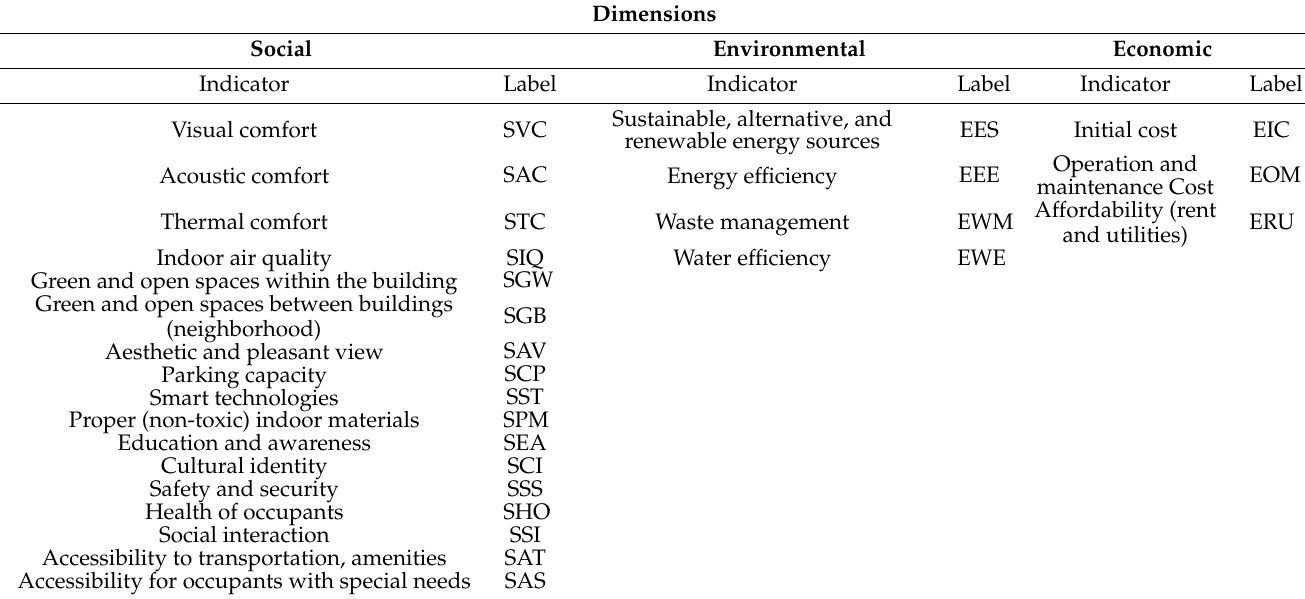
Table 1. Sustainability Indicators for UAE’s Residential